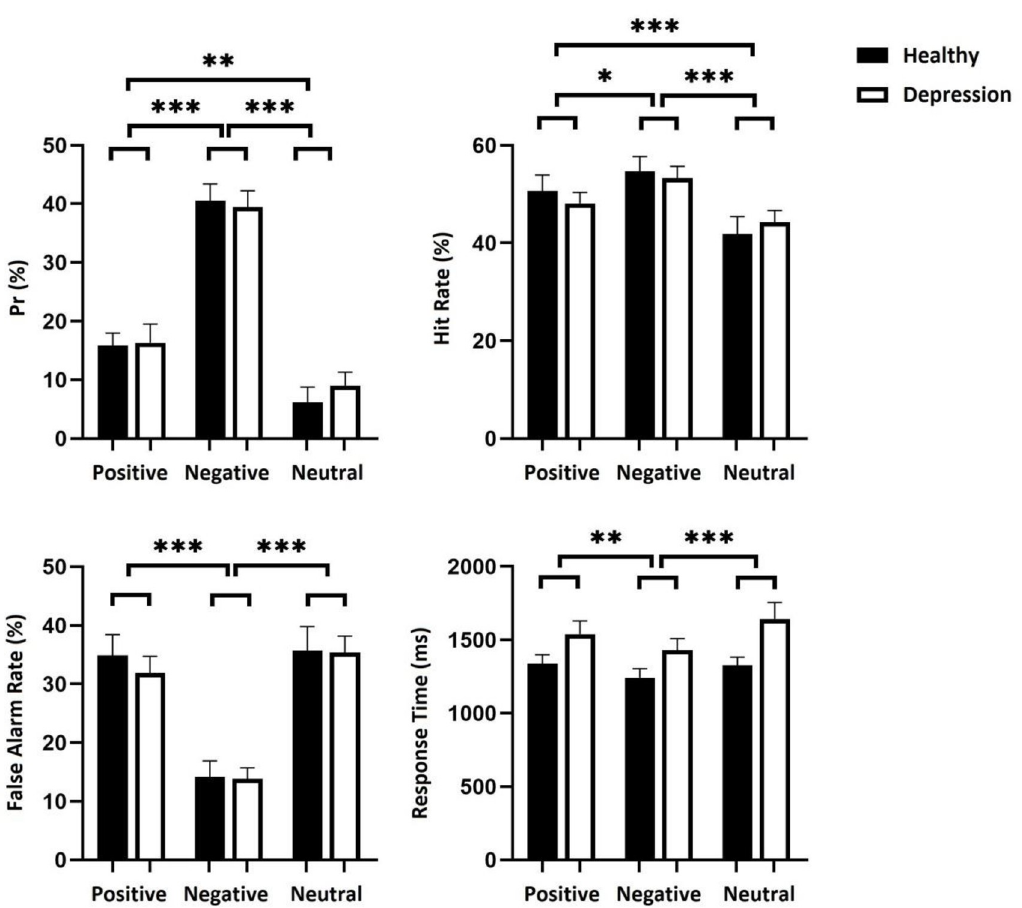
Fig 2. Pr, hit rate, false alarm rate and mean RT in Experiment 2. Error bars represent standard errors. � p < 0.05; �� p < 0.01; ��� p <